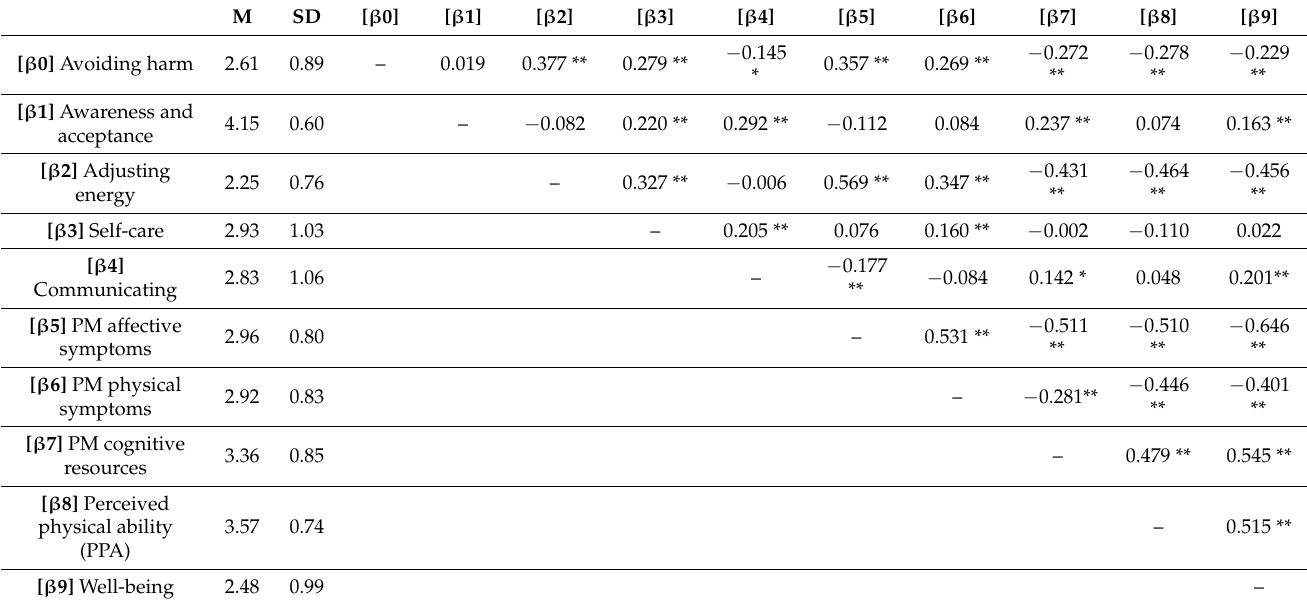
Table 2. Means (M), standard deviations (SD), and Pearson’ correlation coefficients for the study